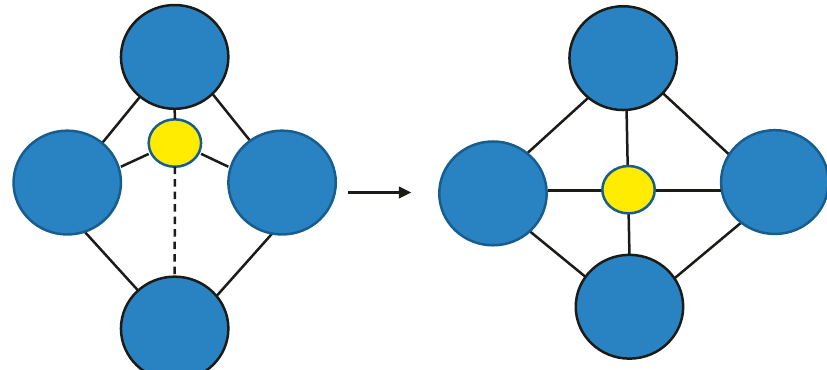
Figure 3: Formation of Pd